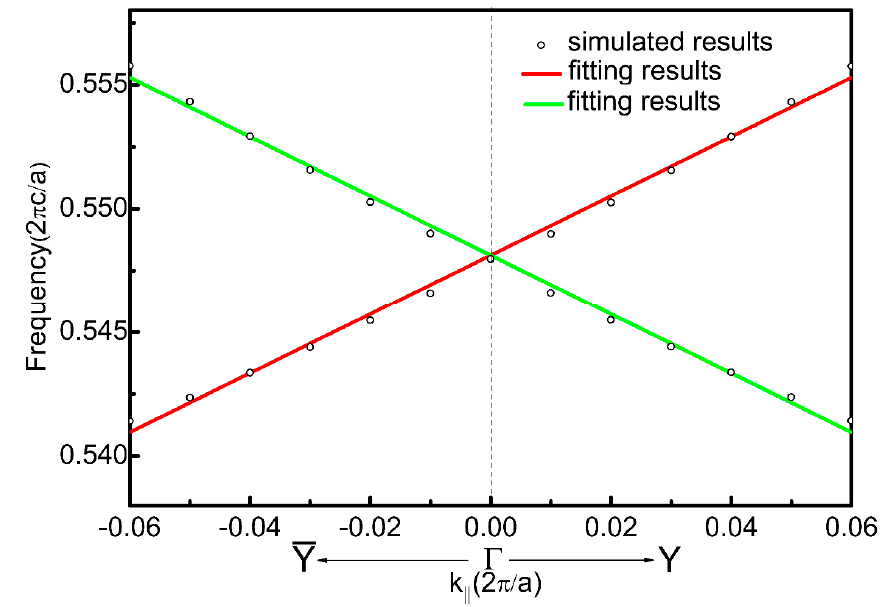
Figure 5. The dispersion relation for edge states. The solid lines and open circles represent the theoretical results according to Equation (6) and the simulation data, respectively.